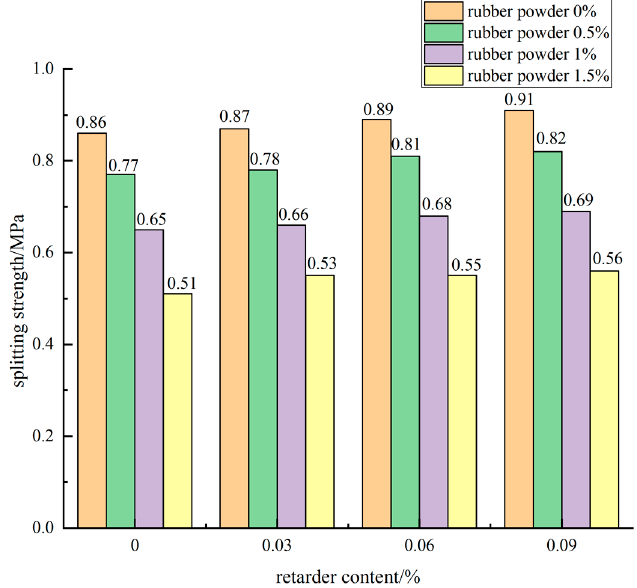
Figure 14. Effect curve of retarder content on splitting strength.